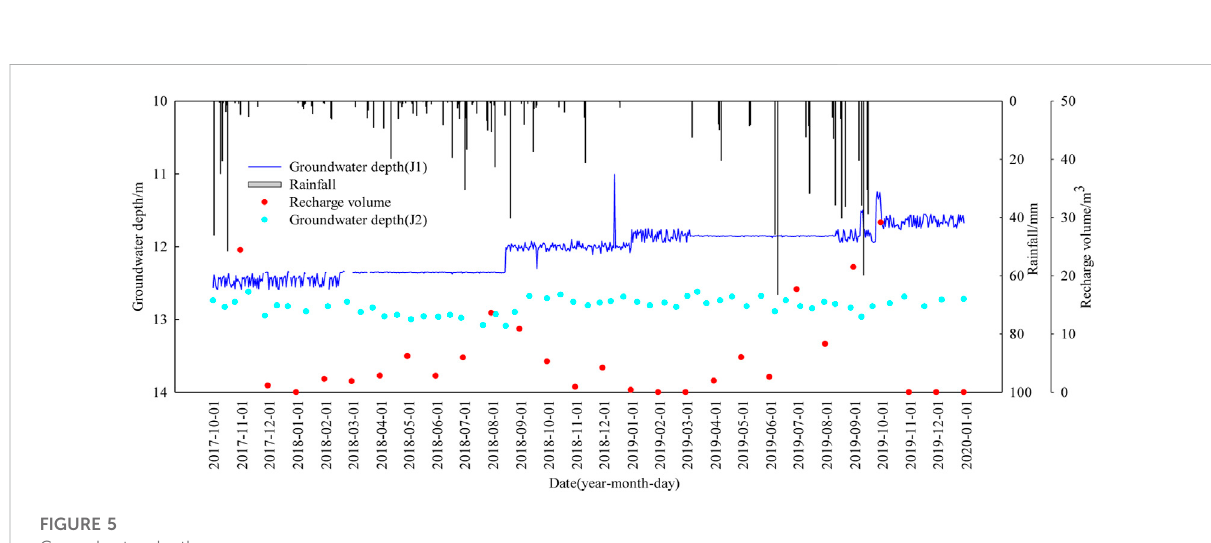
FIGURE 5 Groundwater depth.